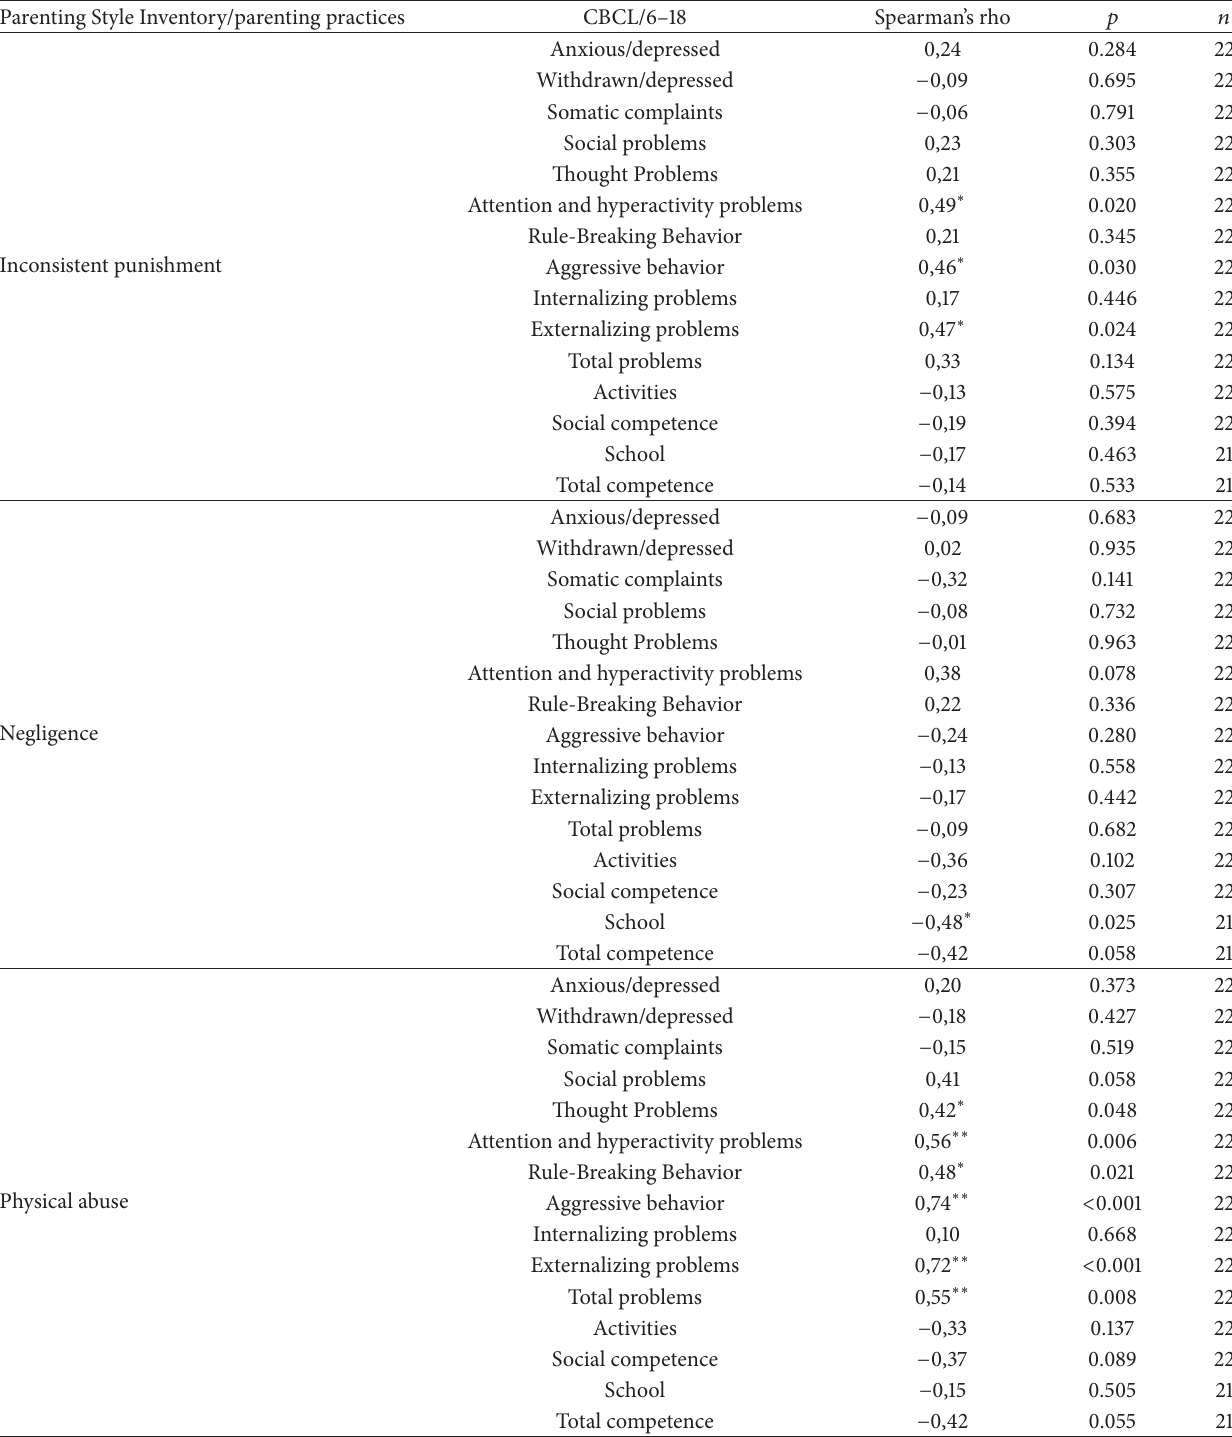
Table 1: Statistically significant correlations between inadequate parenting practices and behavioral problems in children with ADHD. Parenting Style Inventory/parenting